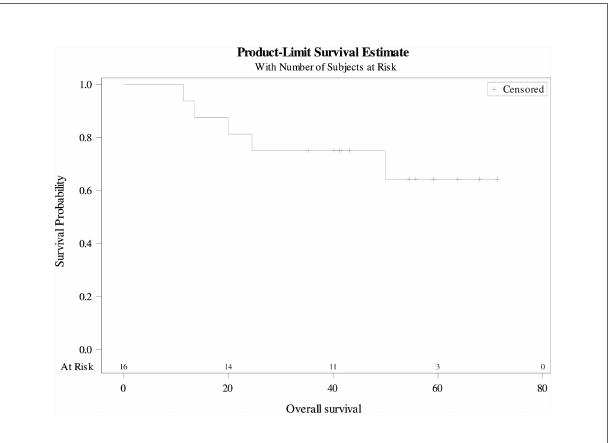
FIGURE 4 | Overall Survival.